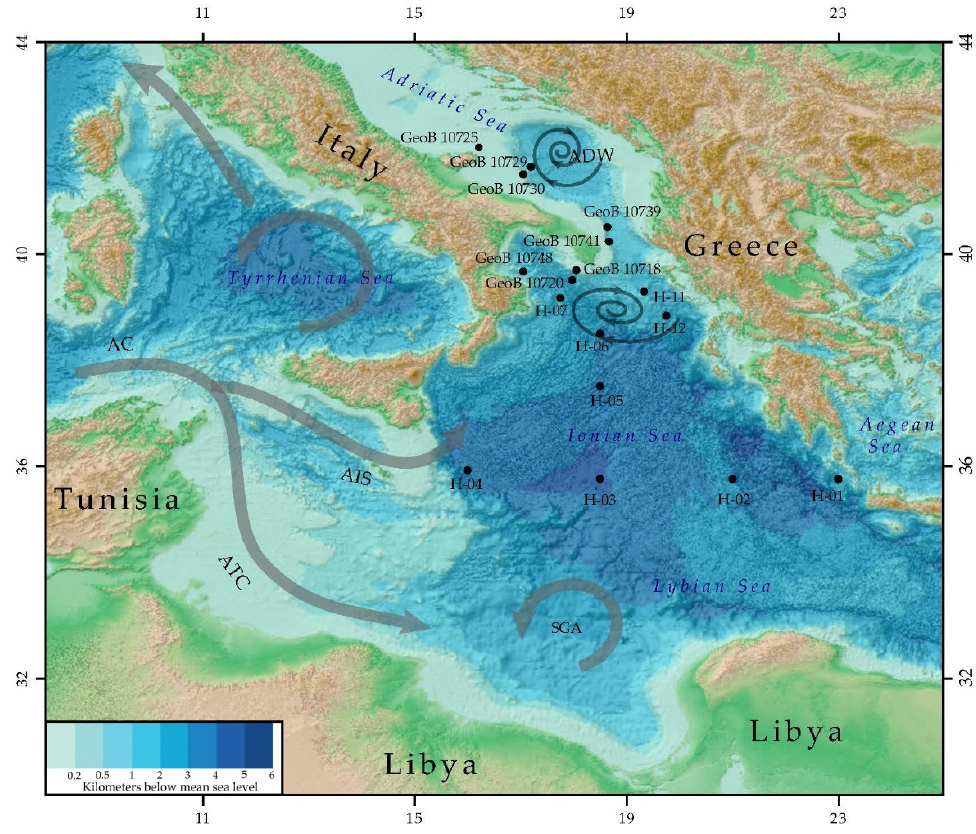
Figure 1. Bathymetric map of the central Mediterranean depicting the sampling locations in the Adriatic and Ionian sub-basins along with the upper ocean current system in the study area.